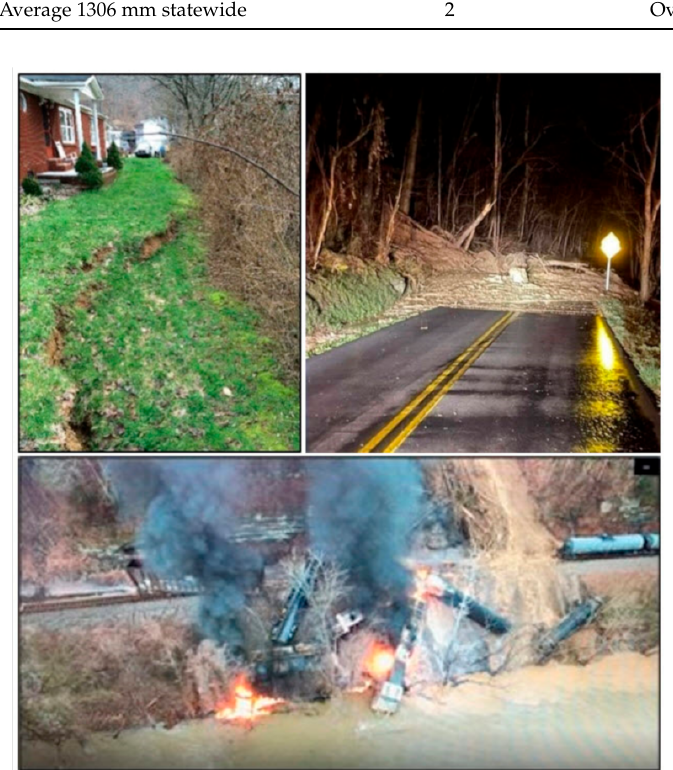
Figure 2. Landslide head scarp threatening a home in Floyd County (upper left, photo credit Matt Crawford), landslide on road in Johnson County (upper right, photo credit Johnson County Emergency Management), and a debris flow that caused a train derailment in Pike County (bottom, photo credit Pike County Emergency